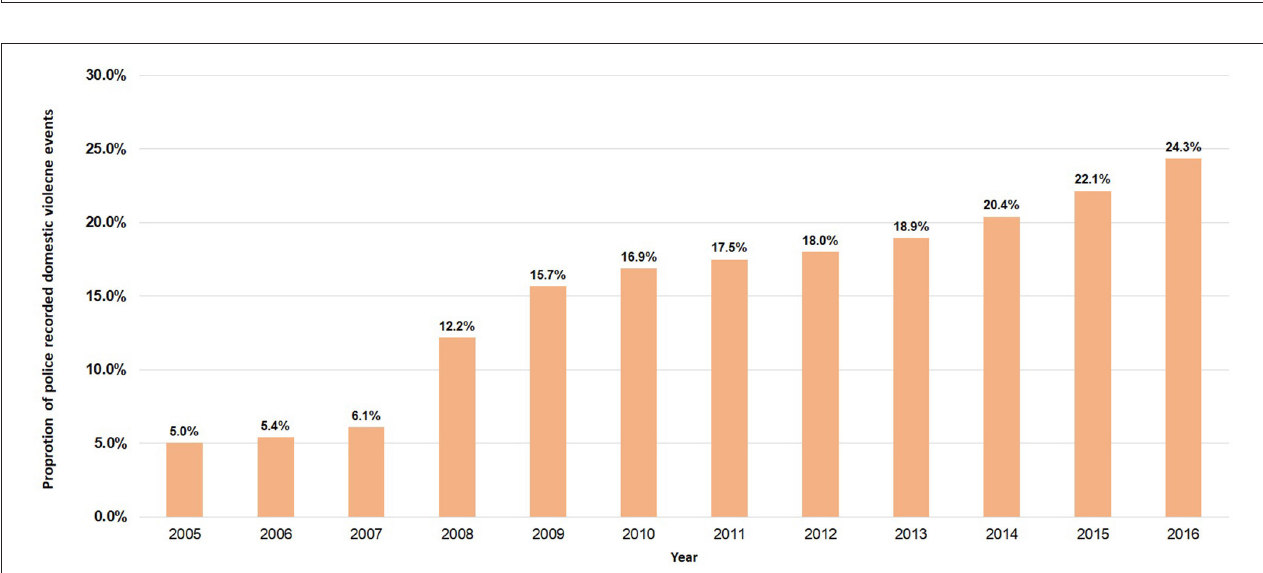
FIGURE 8 | Trend in the proportion of police recorded domestic violence events ( N = 416,441) that reported a mental illness in NSW, January 2005–December 2016.